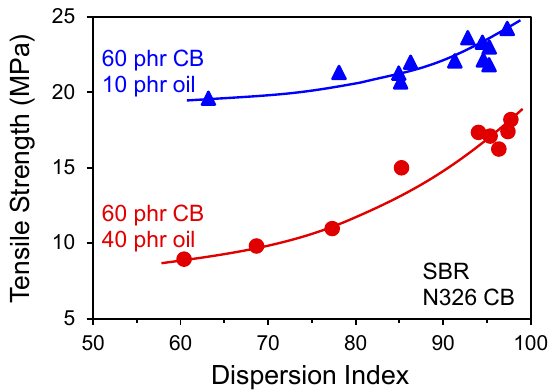
Figure 14. Effect of CB macrodispersion on tensile strength for filled SBR with the indicated loadings of CB and oil. Data replotted from Hess and coworkers [88].